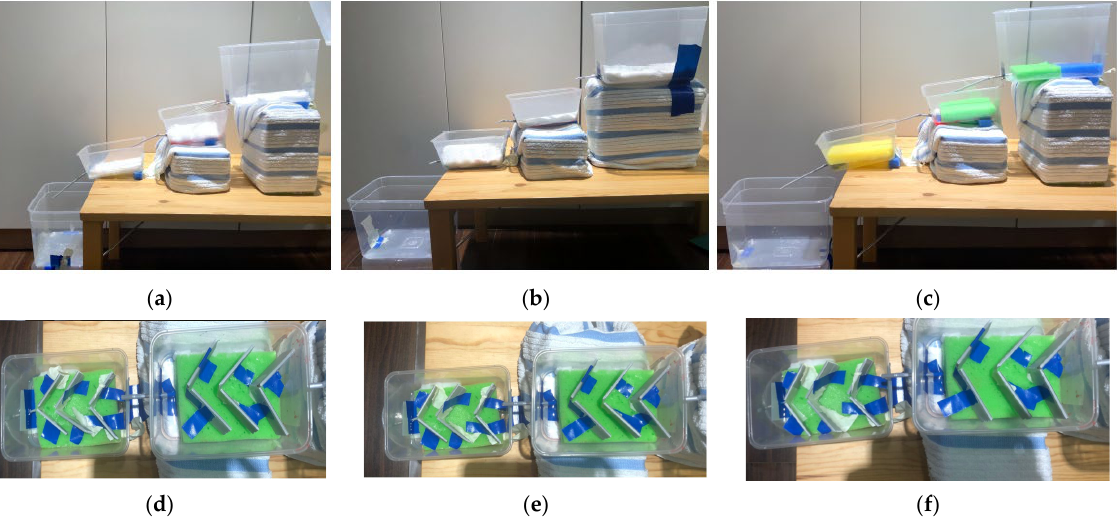
Figure 7. Prototype model testing different angles of wetlands and their water retention capacity. ( a ) 2 ◦ angle with a cotton pad; ( b ) 8 ◦ angle with cotton cloth; ( c ) 12 ◦ angle with a sponge; ( d ) 30 ◦ angle panels with 10 plicate leaves; ( e ) 50 ◦ angle panels with 13 plicate leaves; and ( f ) 70 ◦ angle panels with 15 plicate leaves. Photos: